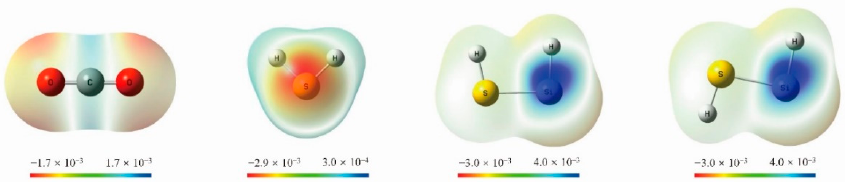
Figure 5. Dual descriptors computed for the H 2 S, CO 2 , and cis -/ trans -HSiSH molecules; nucleophilic and electrophilic zones are represented in red and blue, respectively (isovalue for surfaces: ρ = 0.01 a.u.).